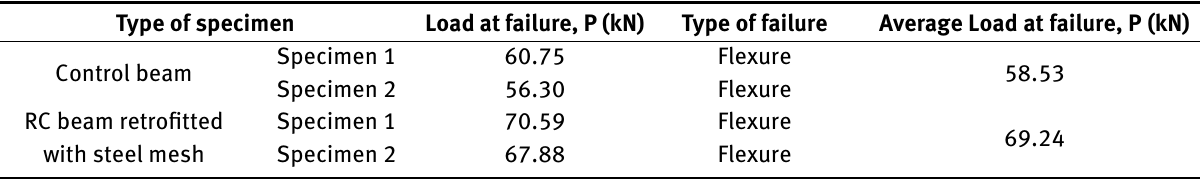
Table 4: Experimental test results of RC beam.